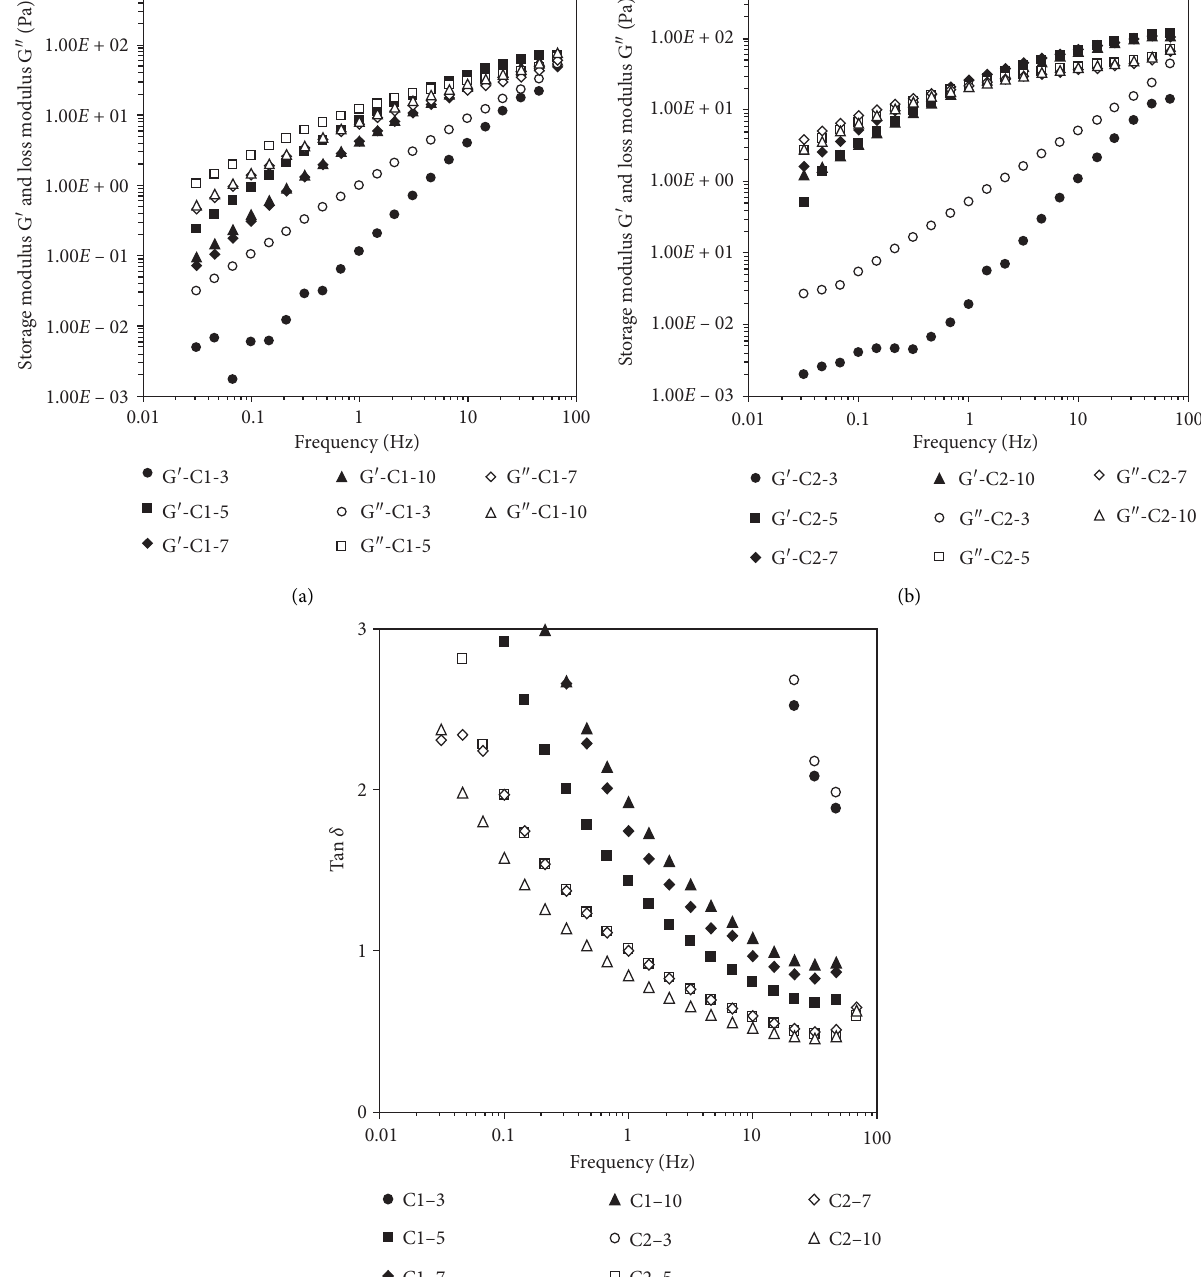
obtained for C1-5 and C1-7 was 370% and 343%, respec- tively. It might be because of the water-washing process of hydrogel leading to the macrocation elimination from the hydrogel. The complex between the [DMAc–Li] + ion and the chitin molecule was decomposed through solvation by water. As a consequence of reduced solvent power, chitin